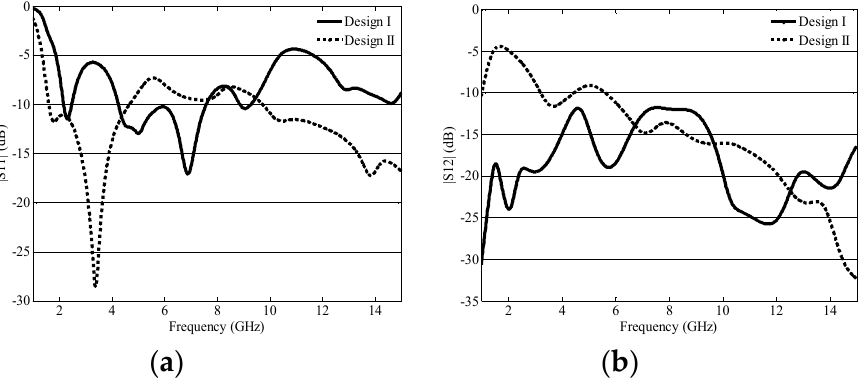
Figure 4. The simulated S-parameters ( a ) S11 and ( b ) S12.